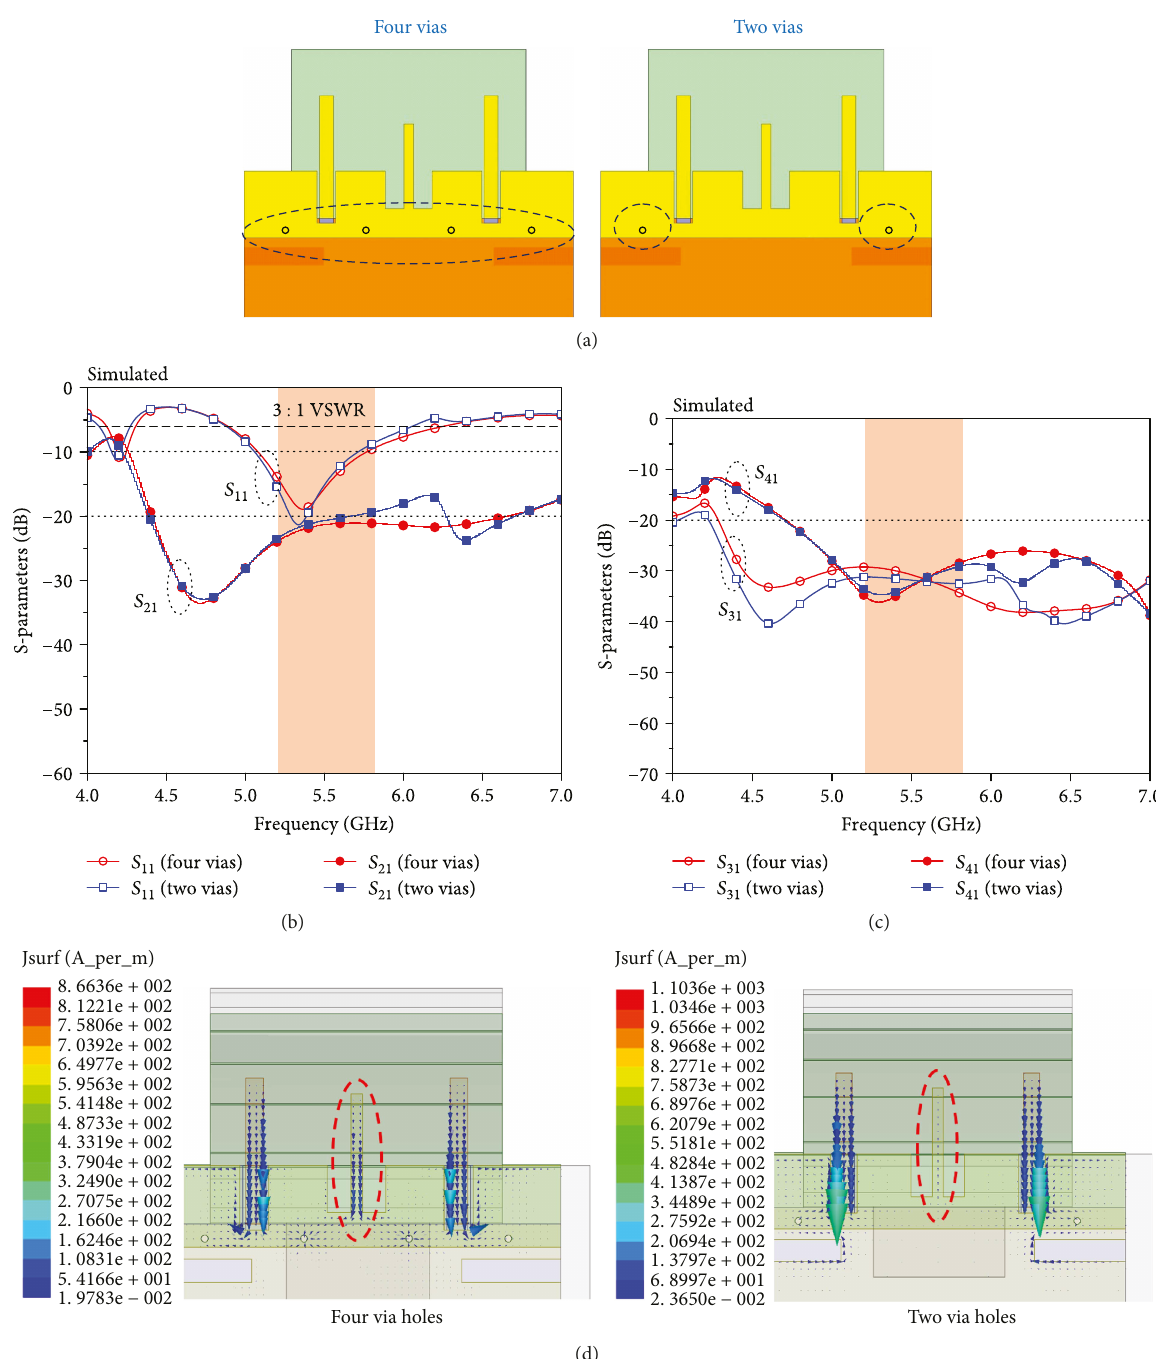
Figure 6: (a) Structures with four and two via holes. (b) Simulated S 11 and S 21 and (c) S 31 and S 41 for the four-element MIMO antenna with via holes. (d) Simulated surface current distributions over the four and two via holes at 5.8